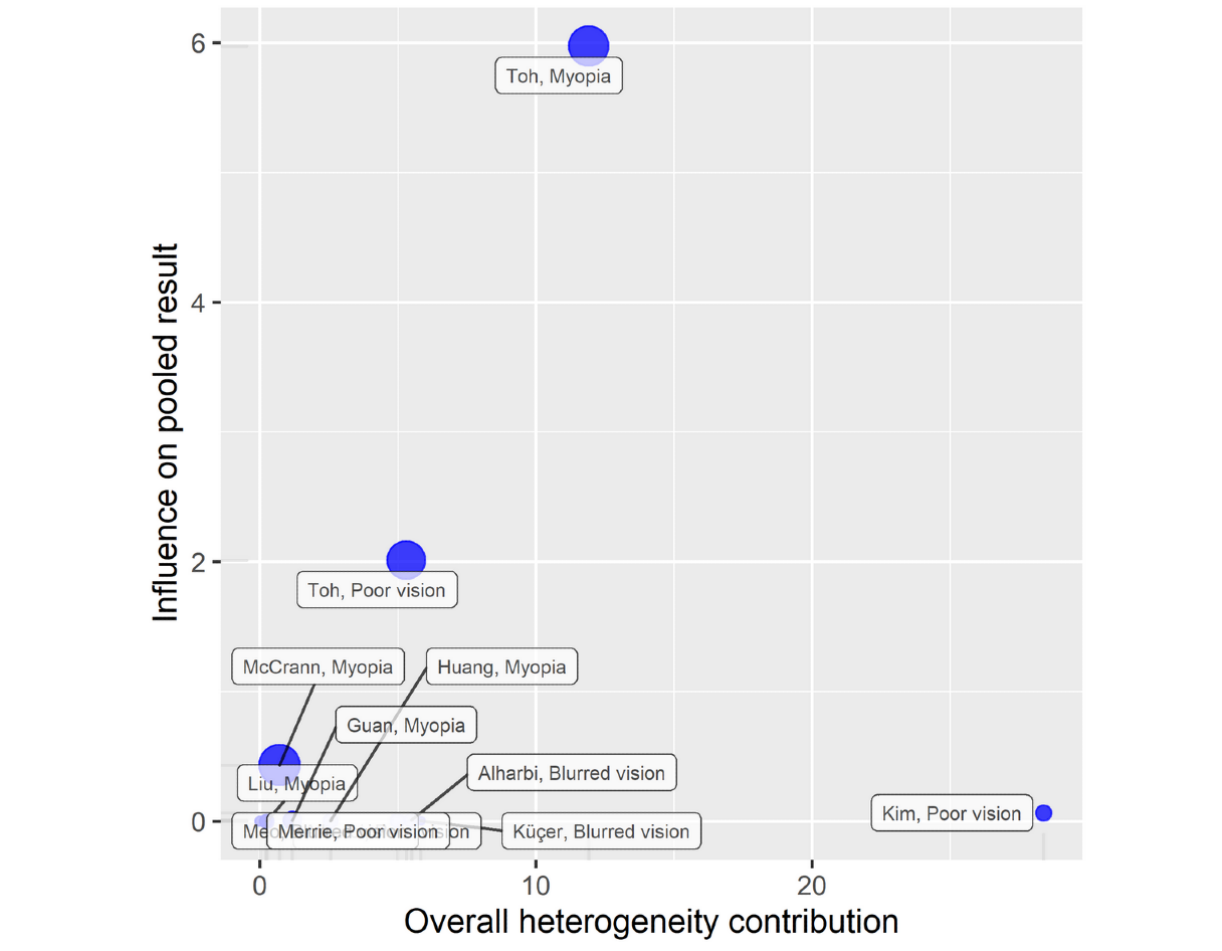
Figure 4. Baujat plot for cross-sectional studies.